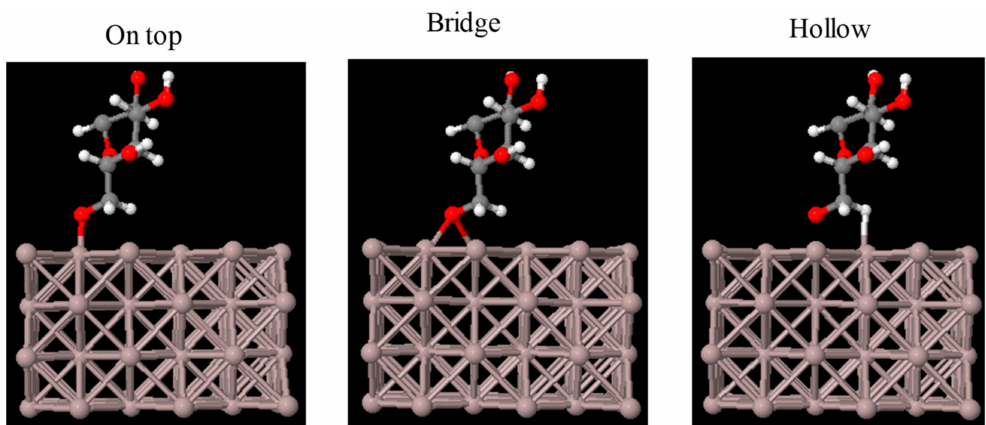
Figure 2. Relaxed Cellulose molecule deposited on an Al(100) surface at different deposition